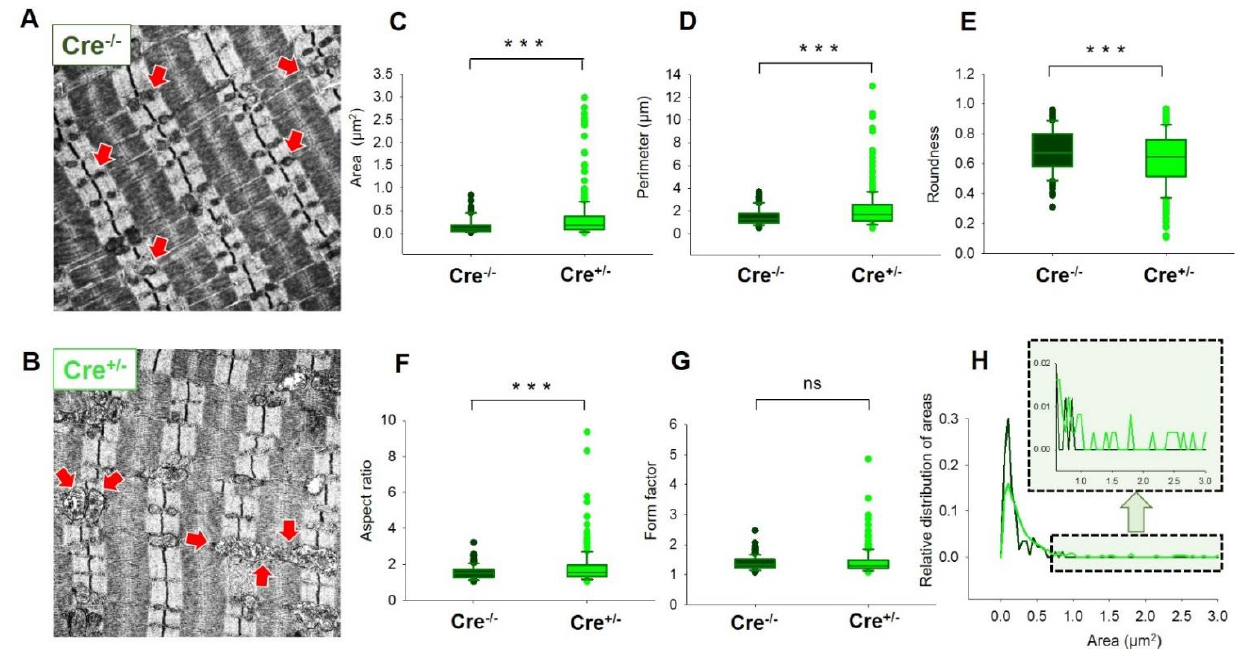
Figure 7. Significant mitochondrial morphology alterations in Cre +/ − muscles. Representative electron micrographs of myofibrils from longitudinal sections obtained on TA muscles samples from Cre − / − ( A ) and Cre +/ − ( B ), depicting drastically altered mitochondrial morphology. The arrows indicate the mitochondria that are placed at the I band next to triads, always on the side closer to the Z line. Box plot representation of the morphological analysis of the individual mitochondria ( n = 168 for Cre − / − and n = 245 for Cre +/ − N = 3 mice/group) concerning the area ( C ), perimeter ( D ), roundness ( E ), aspect ratio ( F ), and form factor ( G ) determined from similar EM images as shown in panels ( A , B ). *** p < 0.001, ns: not significant. ( H ) Relative distribution of areas depicts a rightward shift in Cre +/ − muscles. The highlighted area illustrates a zoomed in view into this phenomenon.